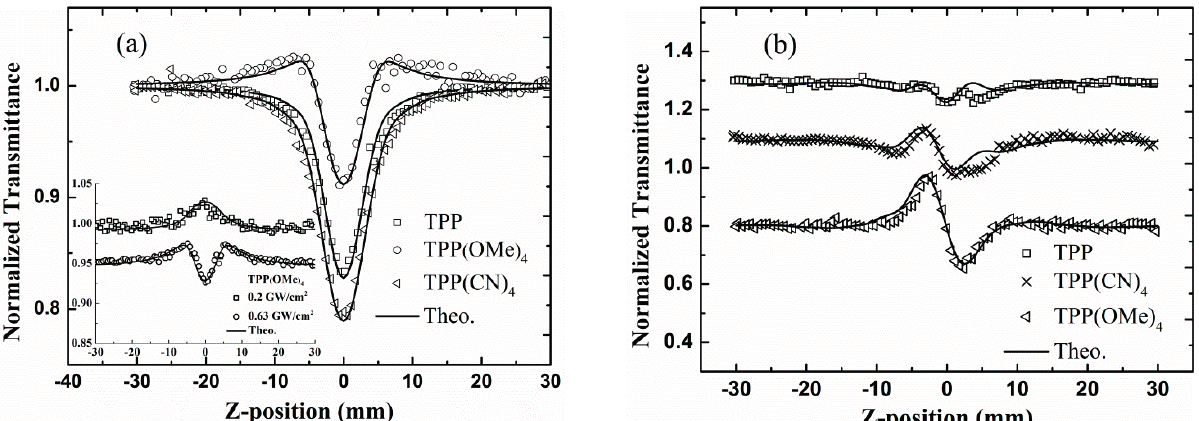
Figure 4. Open ( a ) and closed aperture ( b ) Z-scan data of TPP, TPP(CN) 4 , and TPP(OMe) 4 with 21 ps pulses, on-axis intensity of 1.1 GW/cm 2 . Solid lines are